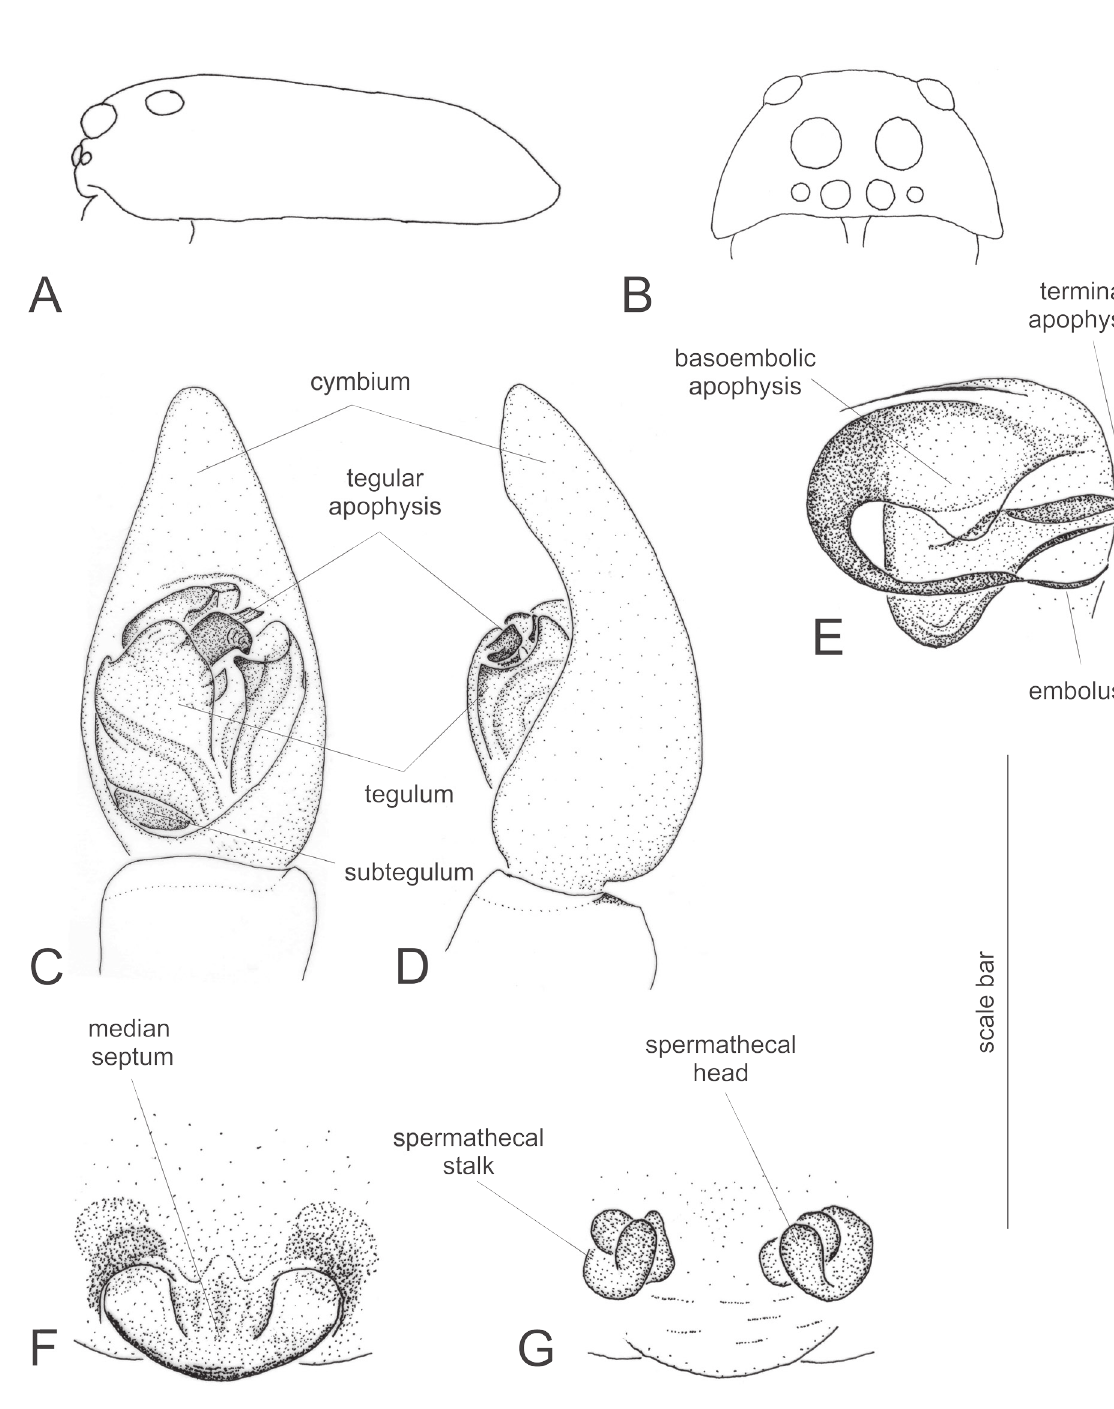
Fig. 6. Tetralycosa oraria (L. Koch, 1876), ♂ (WAM 71/360) and female (WAM 71/361). A–B . Male carapace, lateral and frontal view. C–D . Left male pedipalp, ventral and retrolateral view. E . Left male pedipalp, palea section of bulbus, ventral view. F–G . Female epigyne, dorsal and ventral view. Scale bar: A = 4.42 mm; B = 1.88 mm; C–D = 1.28 mm; E = 0.56 mm; F–G = 0.89